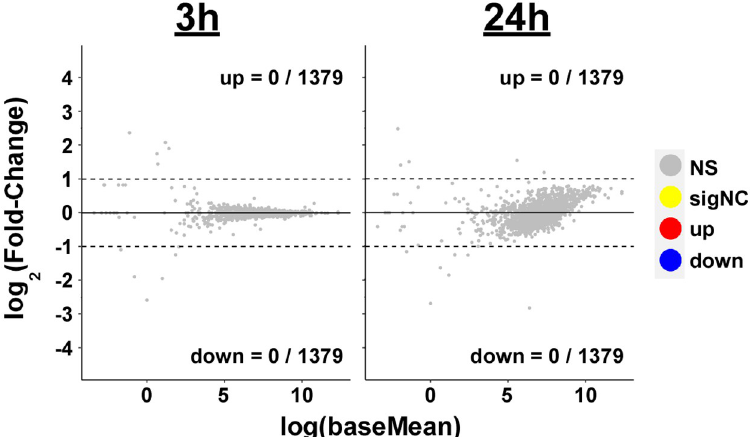
Fig 3. Amoxicillin did not induce gene expression changes. Fold change versus expression strength for all detectable genes after 3 or 24 hours amoxicillin treatment compared to untreated controls. No genes were significantly different between treatment and control groups ( α = 0.05), as indicated by gray dots (“NS”).